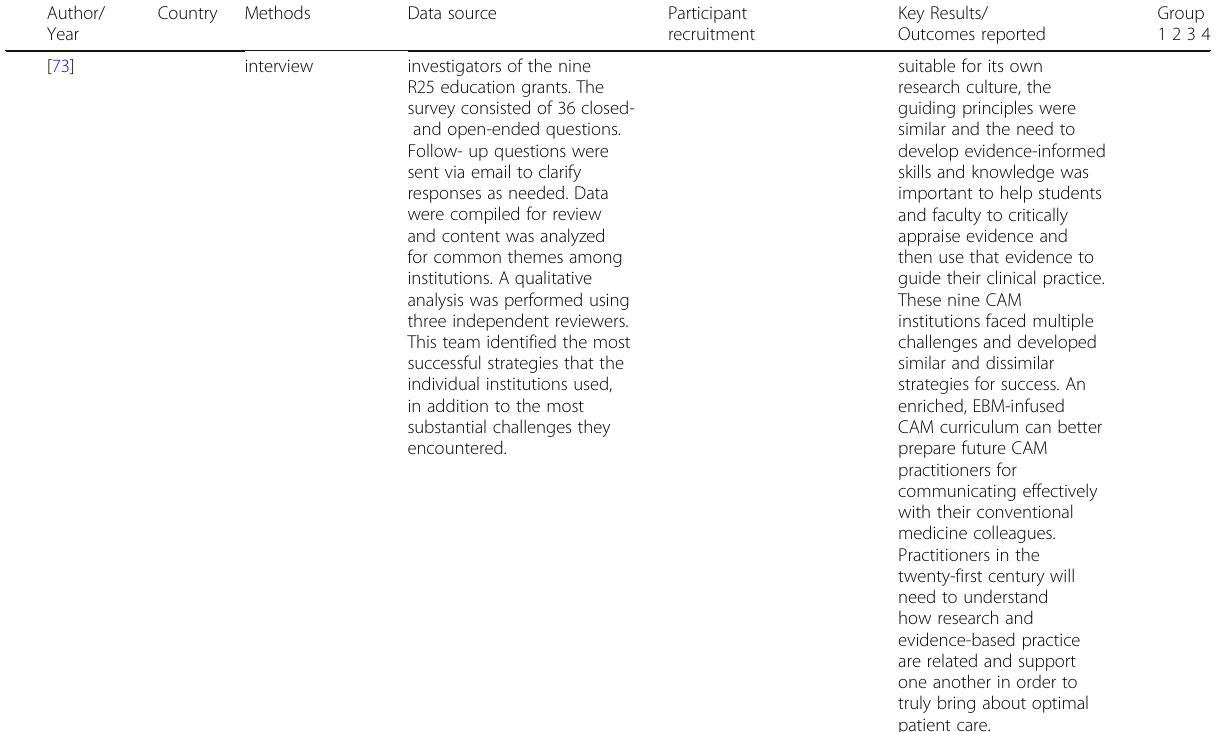
Table 2 Study Characteristics of Included Studies and Thematic Categories (1 CM education provision, 2 The development of educational competencies to develop clinical skills and standards, 3 Application of new educational theory, methods and technology in CM, 3 Future Challenges facing CM education)